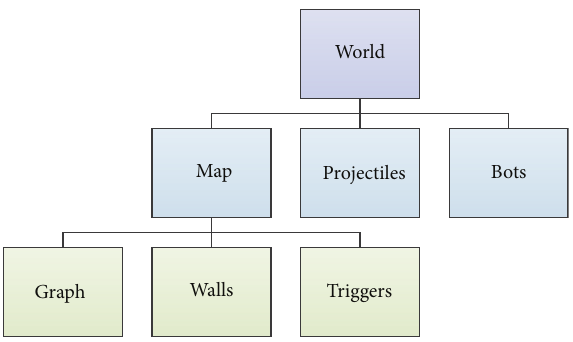
Figure 15: Overview of the Raven world